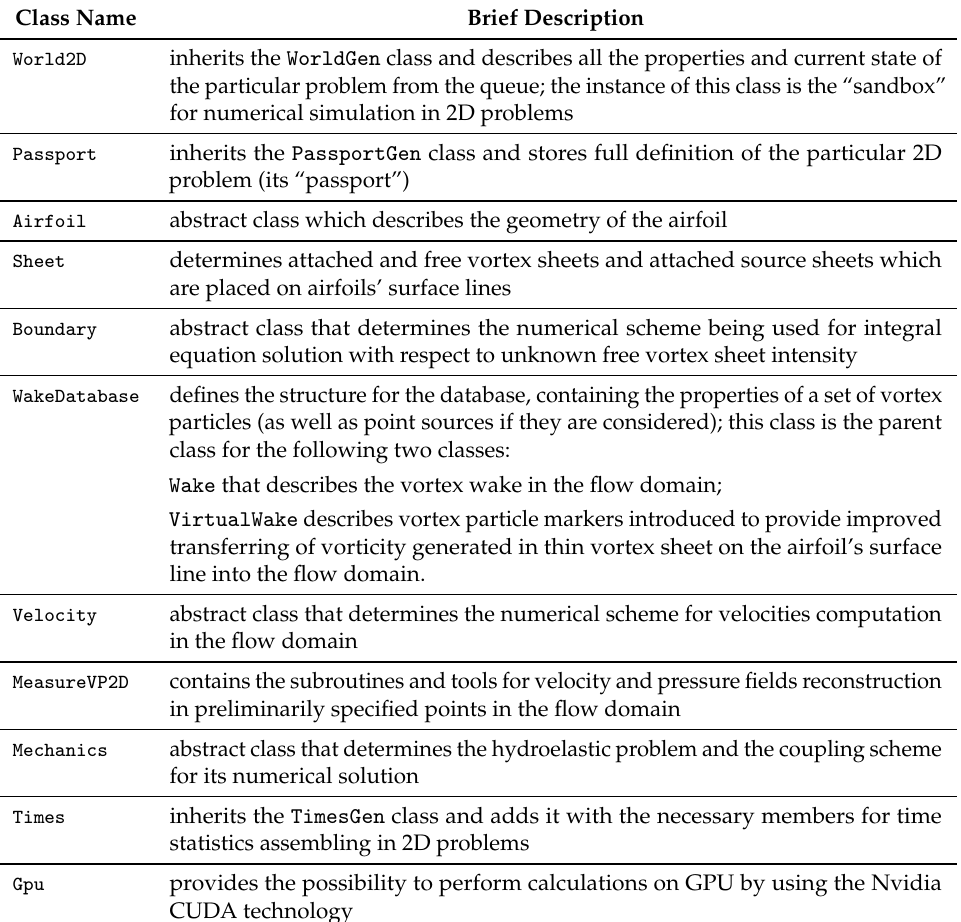
Table 2. Classes defined in VM2D